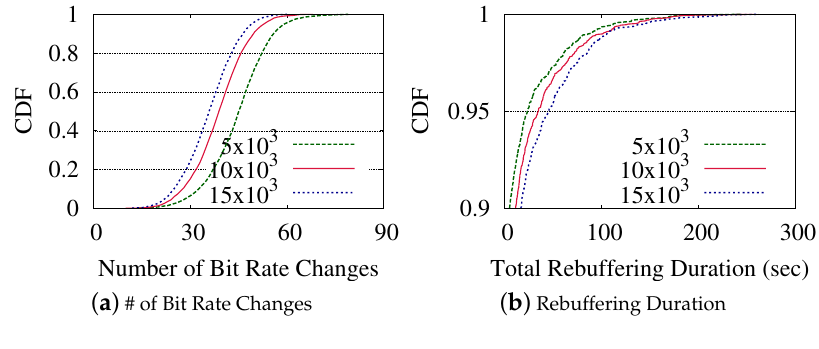
Figure 4. Effect of ρ (LQE).